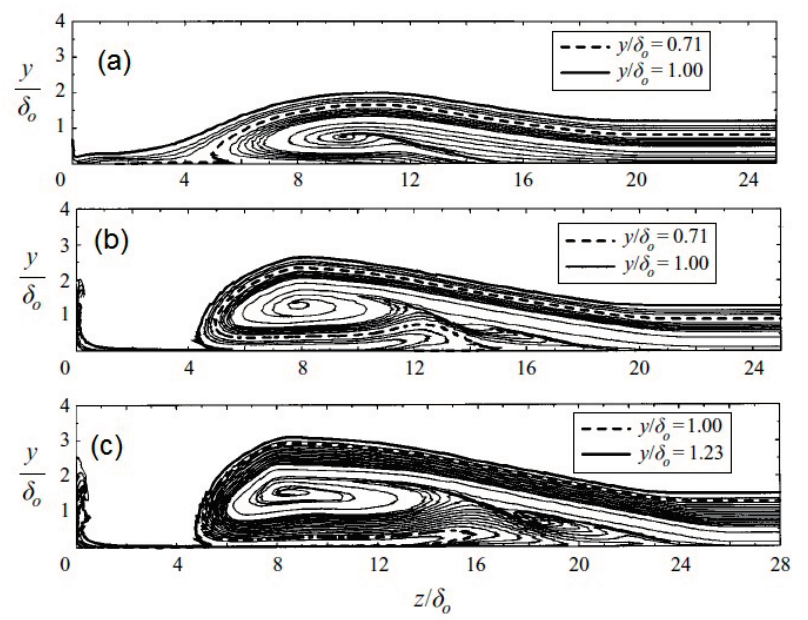
Figure 15. Cross-sections of various flows: ( a ) M ∞ = 3.0, α = 10°; ( b ) M ∞ = 4.0, α = 16°; and ( c ) M ∞ = 4.0, α = 20°